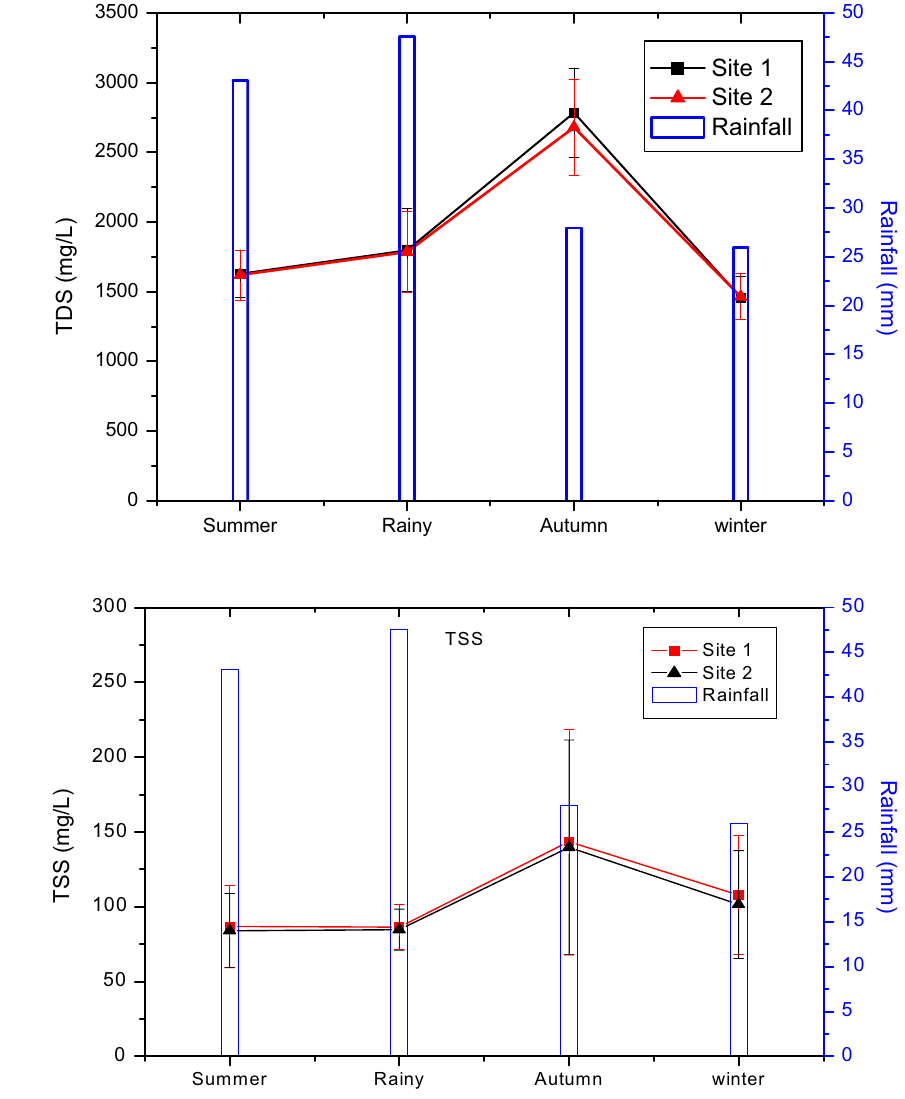
Fig. 4 Average seasonal vari- ations of total dissolved solids (TDS) at different seasons of Site 1 and Site 2 Ludhiana, Punjab (April 2014–2015)